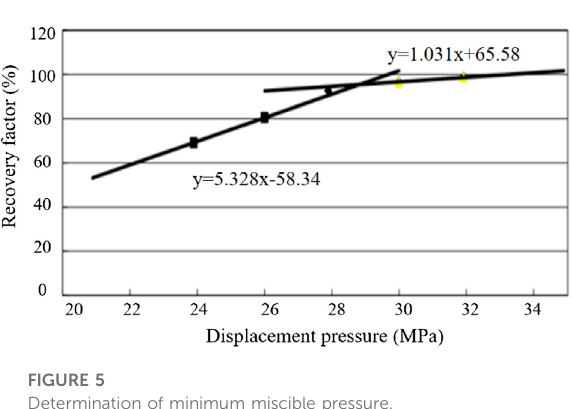
FIGURE 6 Oil displacement ef fi ciency results for different injection methods.